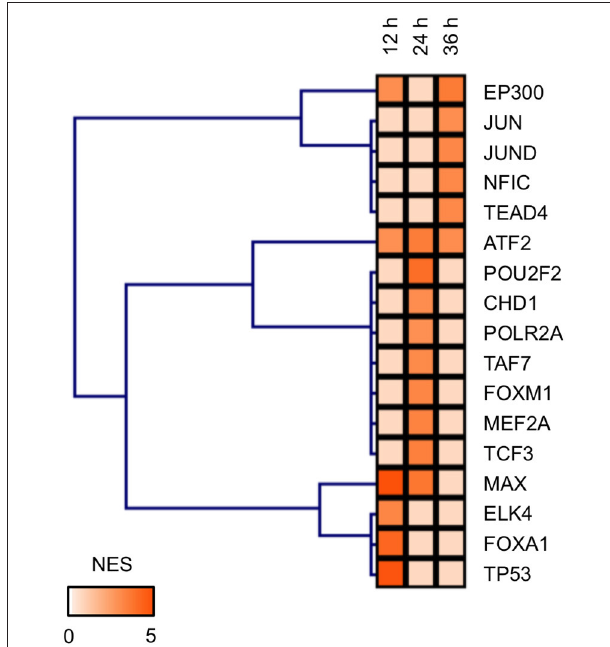
FIGURE 5 | TFs potentially regulating the differentially expressed genes in zebrafish exposed to MBZ. Genes dysregulated in zebrafish exposed to 0.3 µ M MBZ for 12, 24, and 36h were independently subjected to iRegulon. The TFs potentially regulating the dysregulated genes at each time point were subjected to hierarchical clustering using the normalized enrichment score (NES) for significance.